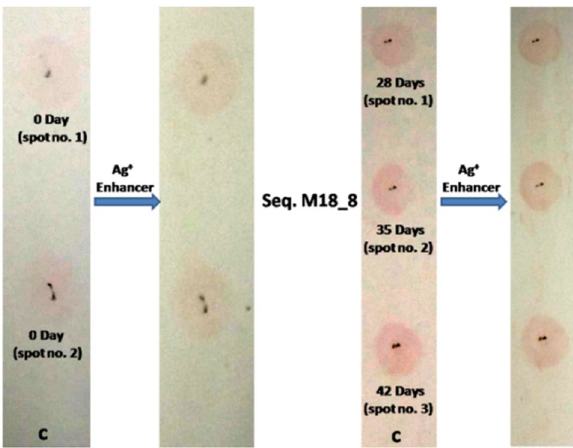
Figure 10. Detection of PAG protein by aptamers at 0 day and at different days after AI.